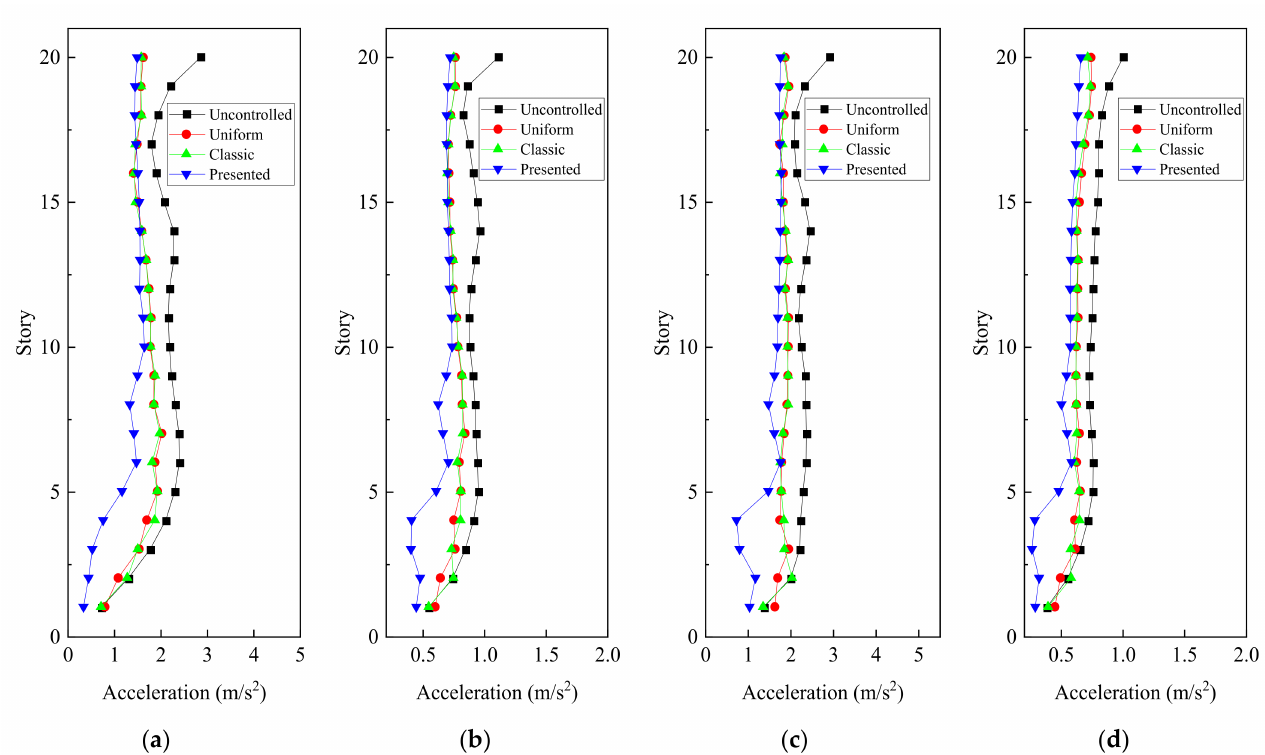
Figure 6. Normed acceleration of each story with different actuator placement: ( a ) Kobe; ( b ) El-Centro; ( c ) Tabas; ( d ) Artificial seismic wave.